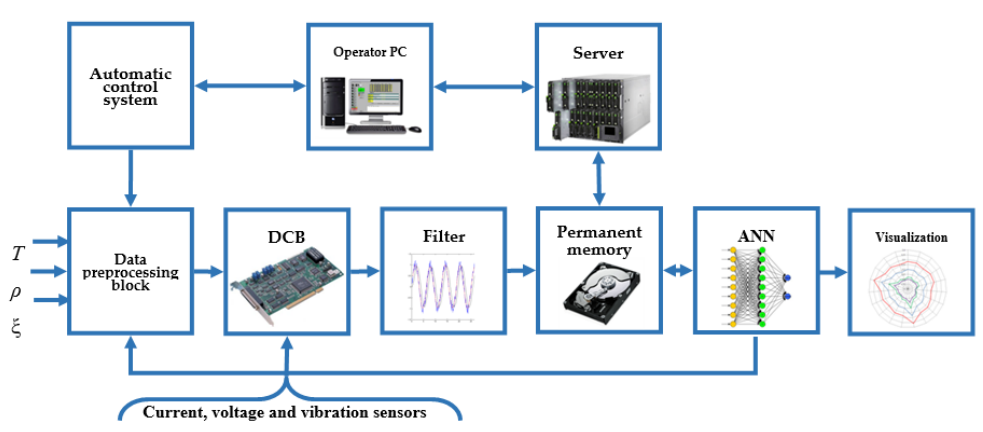
Figure 4. Structural diagram of the system for assessing the probability of failure-free operation by diagnosed electrical and vibration AM parameters using ANN.